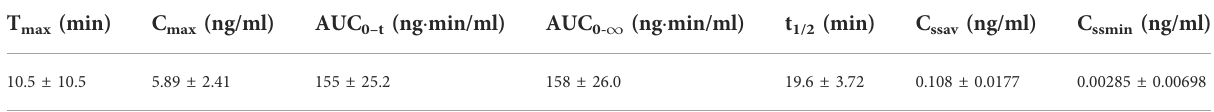
TABLE 6 Pharmacokinetic parameters of BPC157 in dogs following repeated intramuscular administration at a dose of 30 μ g/kg for seven consecutive days (mean ± SD, n =